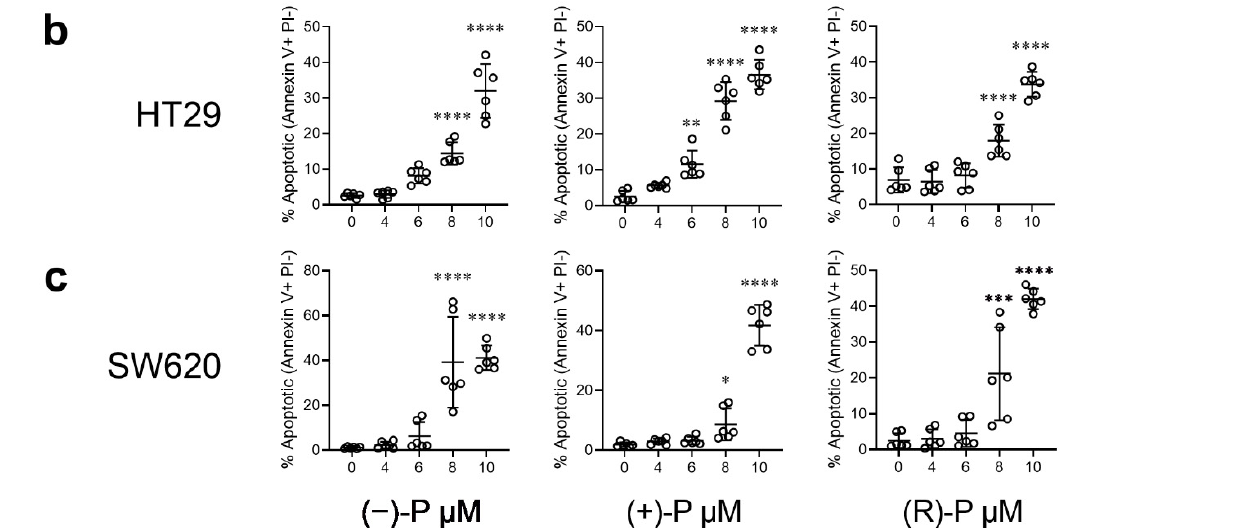
Figure 2. The effect of treatment with ( − )-P, (+)-P, or (R)-P on Annexin V staining in CRC cell lines. HT29 or SW620 cells were treated with different concentrations of -P, (+)-P and (R)-P for 48 h, then stained with Annexin V/PI and analysed by flow cytometry. ( a ) Representative flow cytometry scatterplots, showing viable (Q4, double negative), early apoptotic (Q3, annexin V positive), late apoptotic (Q2, annexin V and PI positive) and necrotic (Q1, PI positive) HT29 cells. ( b ) The percentage of early apoptotic cells in HT29 cultures. ( c ) The percentage of early apoptotic cells in SW620 cultures. Results shown are mean ± SD of early apoptotic cells from technical replicates pooled from three independent experiments. * p ≤ 0.05, ** p ≤ 0.01,*** p ≤ 0.001, **** p ≤ 0.0001. One-way ANOVA with multiple comparisons test against vehicle (0 µM) control.